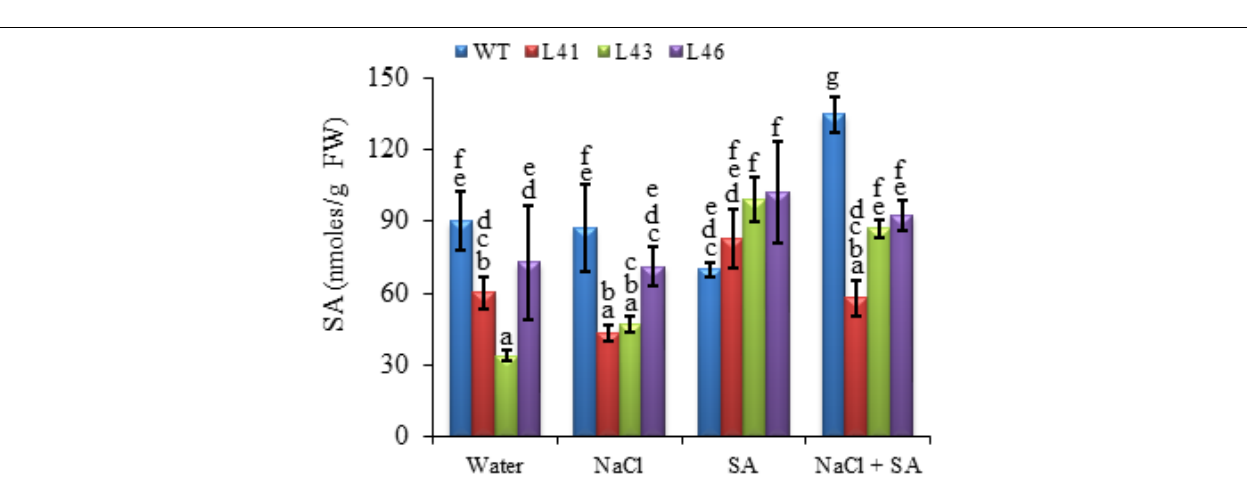
FIGURE 8 | The SA concentration in WT and JcWRKY transgenic lines (L41, L43, and L46) at different NaCl, SA and combined stress treatments. Values are represented as means ± SD ( n = 3) and marked with different alphabets to indicate significant difference at P ≤ 0.05